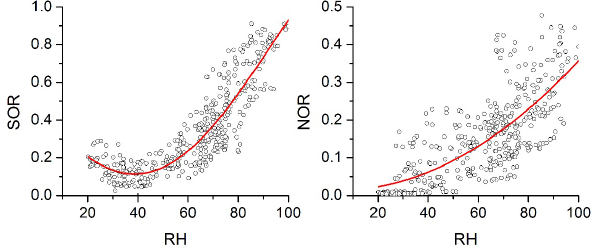
Figure 13. Relationship between RH (%) and SOR and between RH (%) and NOR during the haze episodes in October 2014.